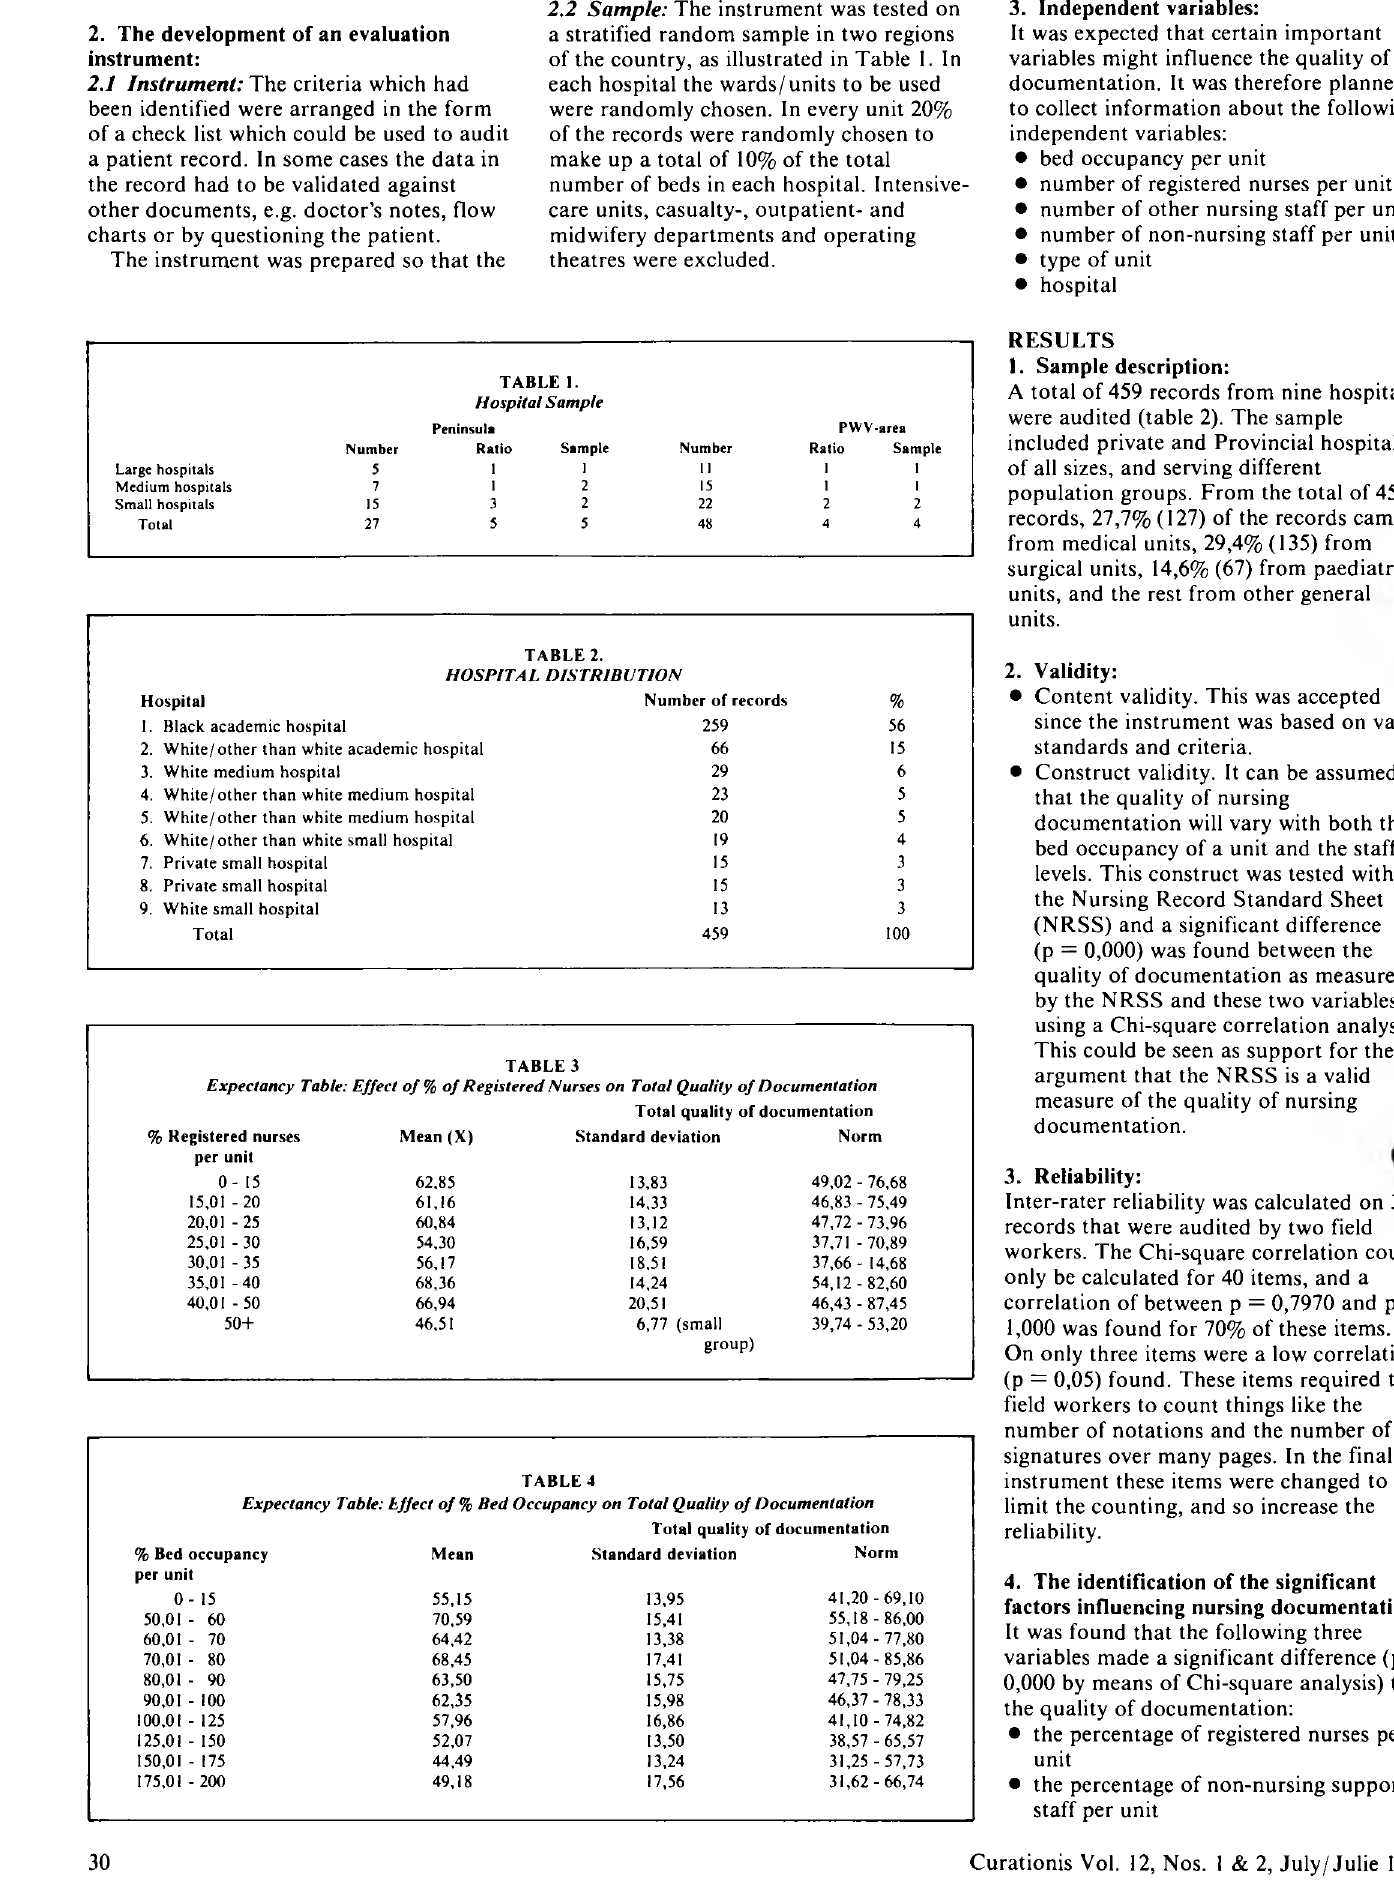
TABLE 3 Expectancy Table: Effect of % of Registered Nurses on Total Quality of Documentation